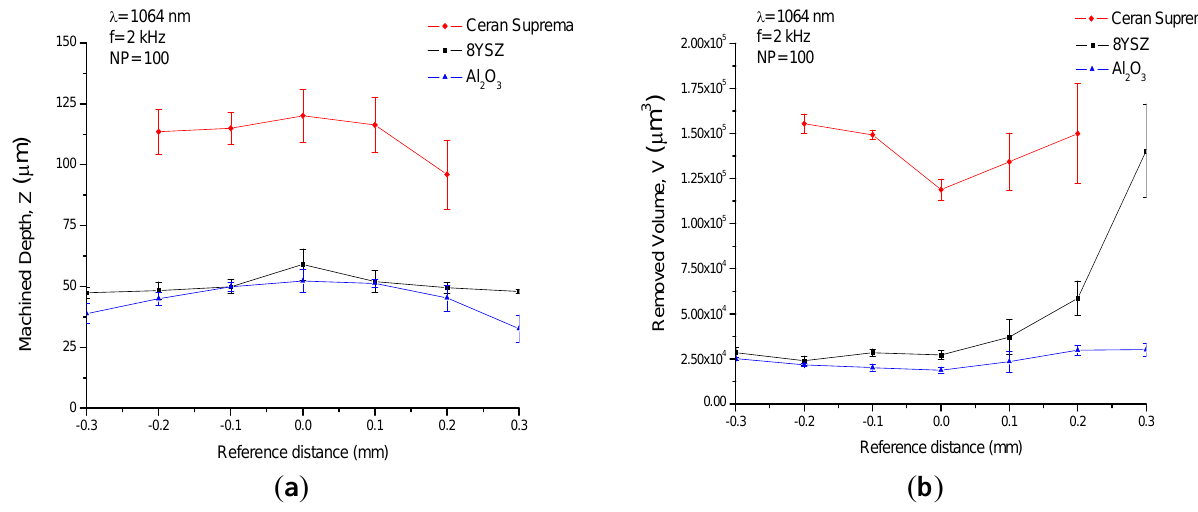
Figure 3. Geometrical dimensions obtained for 8YSZ substrates processed by means of grooves, machining at a wavelength of 1064 nm ( a ); and 532 nm ( b